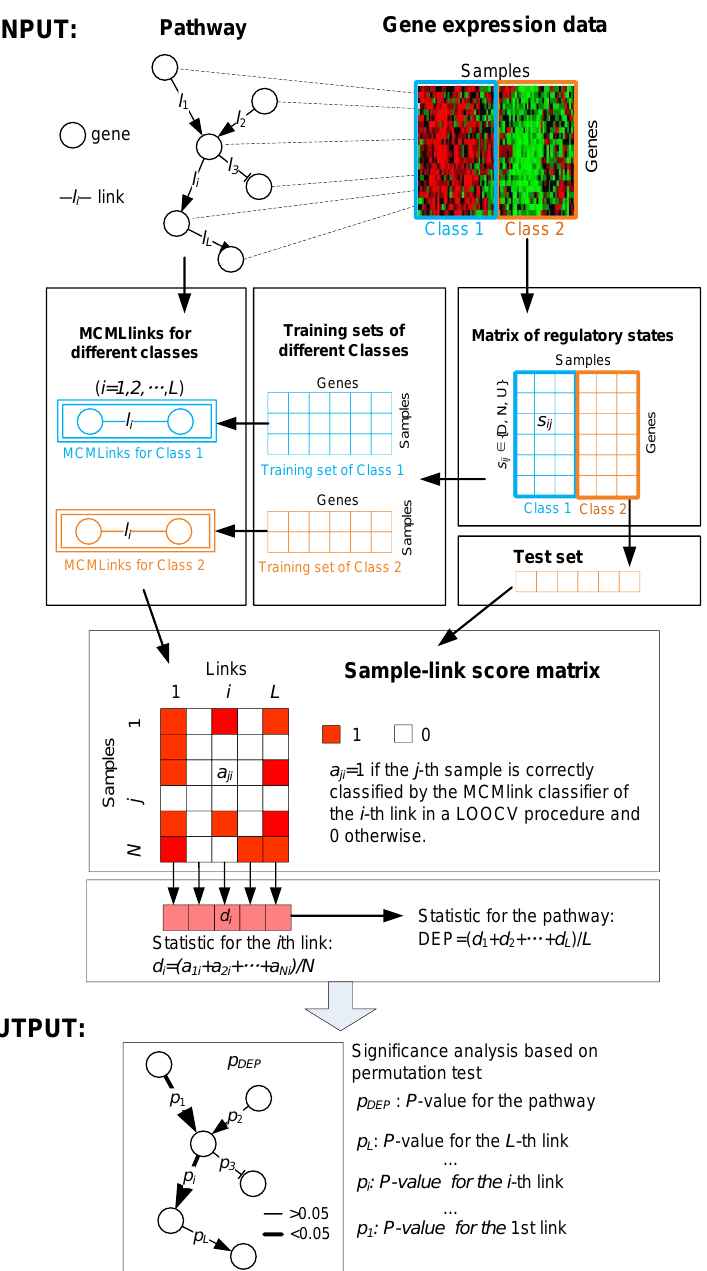
Figure 1. The flowchart of the proposed method DynSig. The raw input data includes an L -link pathway and a continuous expression matrix with sample labels (e.g., Class 1 vs. Class 2 ). The continuous gene expression values are discretized into three regulatory states based on discretization methods: downregulated (D), non-regulated (N) and upregulated (U). Furthermore, all the samples are divided into three sets: two training sets for Class 1 and Class 2 , respectively, and a test set comprising the rest of samples. For the i -th link ( i = 1,2, …, L ) in the pathway, two Markov chain model links (MCMLinks) are built based on the two training sets, respectively. Then, by using the leave-one-out-cross-validation (LOOCV) procedure, the j -th sample is classified by the i -th link and we have a ji = 1 if the classification is right and 0 otherwise. The classification power of the i -th link is calculated by averaging the resulted scores { a ji } j =1,2,…, N , i.e., d i = ( a 1i + a 2i + … + a Ni ) /N and the classification power of the pathway is calculated by averaging the classification powers of all links, DEP = ( d 1 + d 2 + … + d L )/ L . Permutation test is utilized for evaluating p -values of the resulted classification powers.